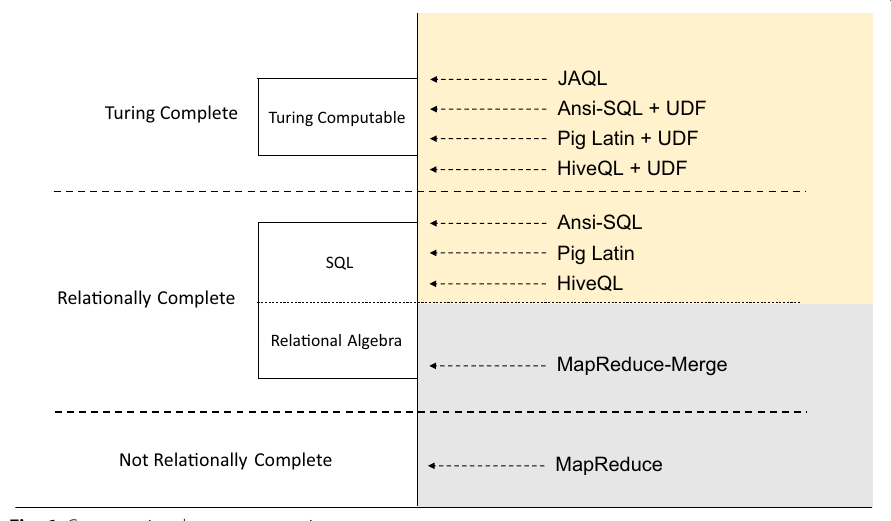
Fig. 6 Computational power